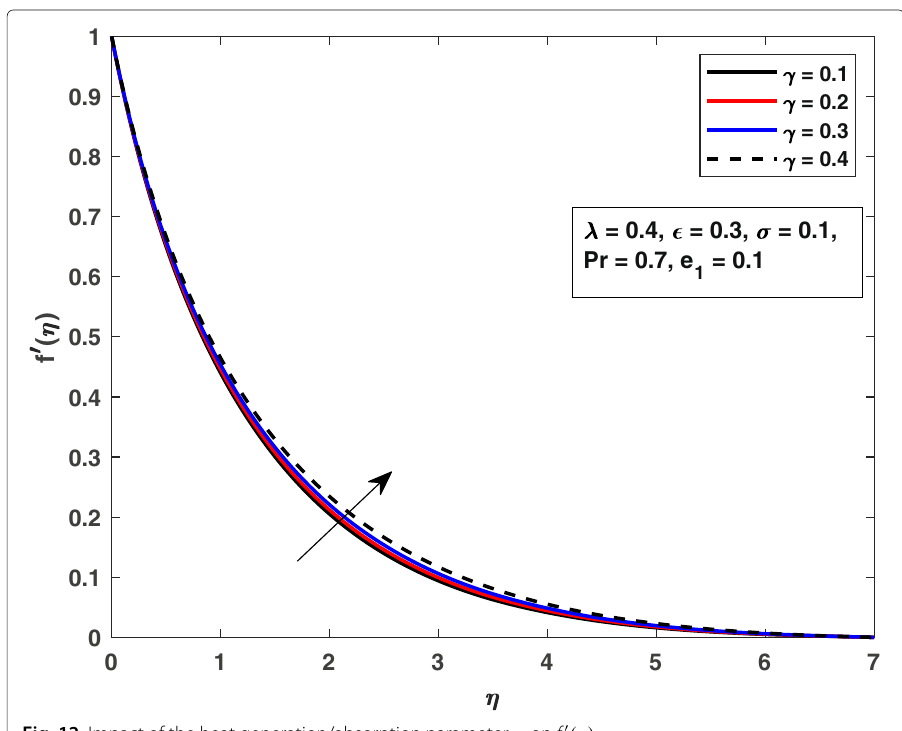
Fig. 12 Impact of the heat generation/absorption parameter γ on f (cid:6) (η)